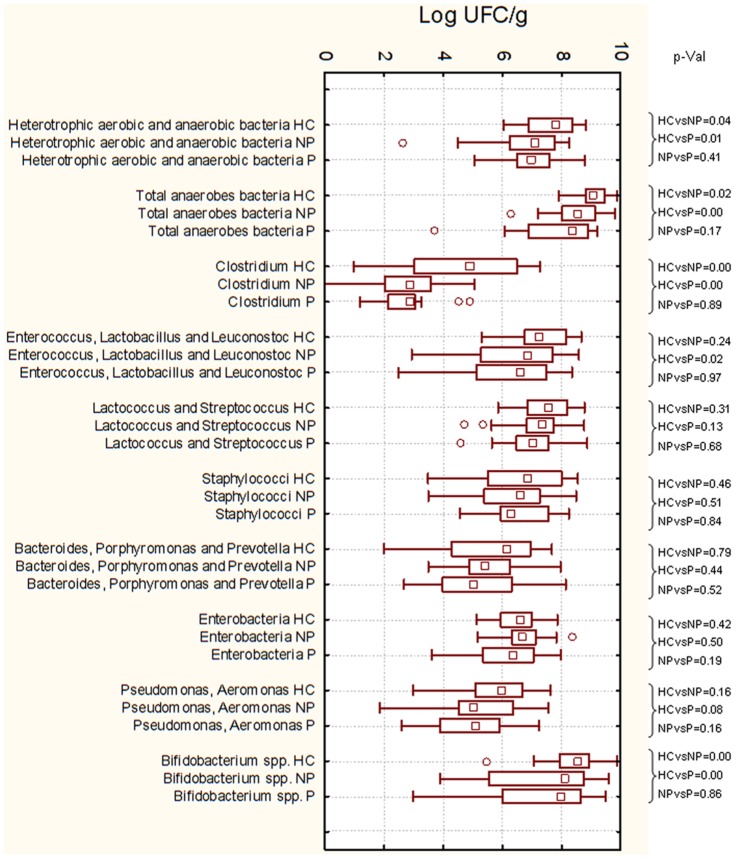
Fecal cultivable bacteria of the main microbial groups.Cultivable cells (log cfu/g) found in the fecal samples of immunoglobulin A nephropathy (IgAN) non progressor (NP) and progressor (P) patients, and healthy controls (HC). Data are the means of three independent experiments (n = 3). The top and bottom of the box represent the 75th and 25th percentile of the data, respectively. The top and bottom of the error bars represent the 5th and 95th percentile of the data, respectively. ○, Outliers data. Group student's t-test p-values were also shown.